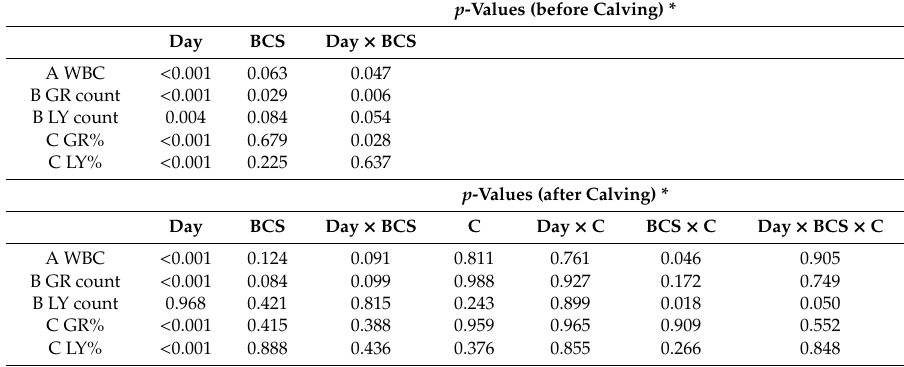
Figure 2. Characteristics of white blood cell counts (WBC, ( A )), as well as counts ( B ) and percentages ( C ) of granulocytes (GR) and lymphocytes (LY) in the course of the experiment. BCS: body condition scores. Ante partum , cows were categorized in high body condition score (BCS, BCS H ,) and adequate BCS (BCS A ,). Post partum , the two groups were subdivided again, each into a group with a concentrate proportion of 60% (C 60, solid line) in the ration (increasing from 35–60% during the first three weeks after calving) and a group with a concentrate proportion of 35% (C 35 , dashed line) in the ration. Thus, four groups emerged: BCS H /C 60 ( n = 15), BCS H /C 35 ( n = 15), BCS A /C 60 ( n = 15), BCS A /C 35 ( n = 15). Table 1. Model corresponding to Figure 2.